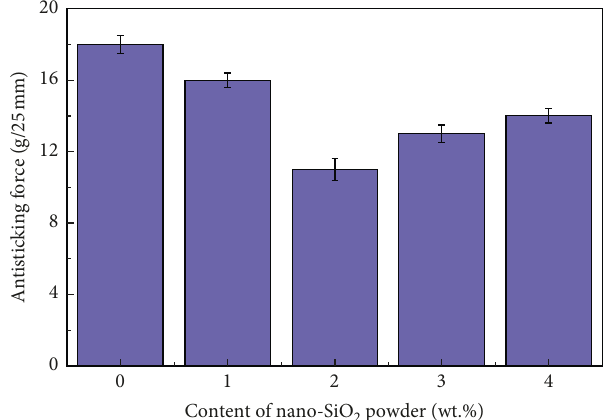
Figure 9: Surface roughness and surface free energy of silicone antisticking coatings.